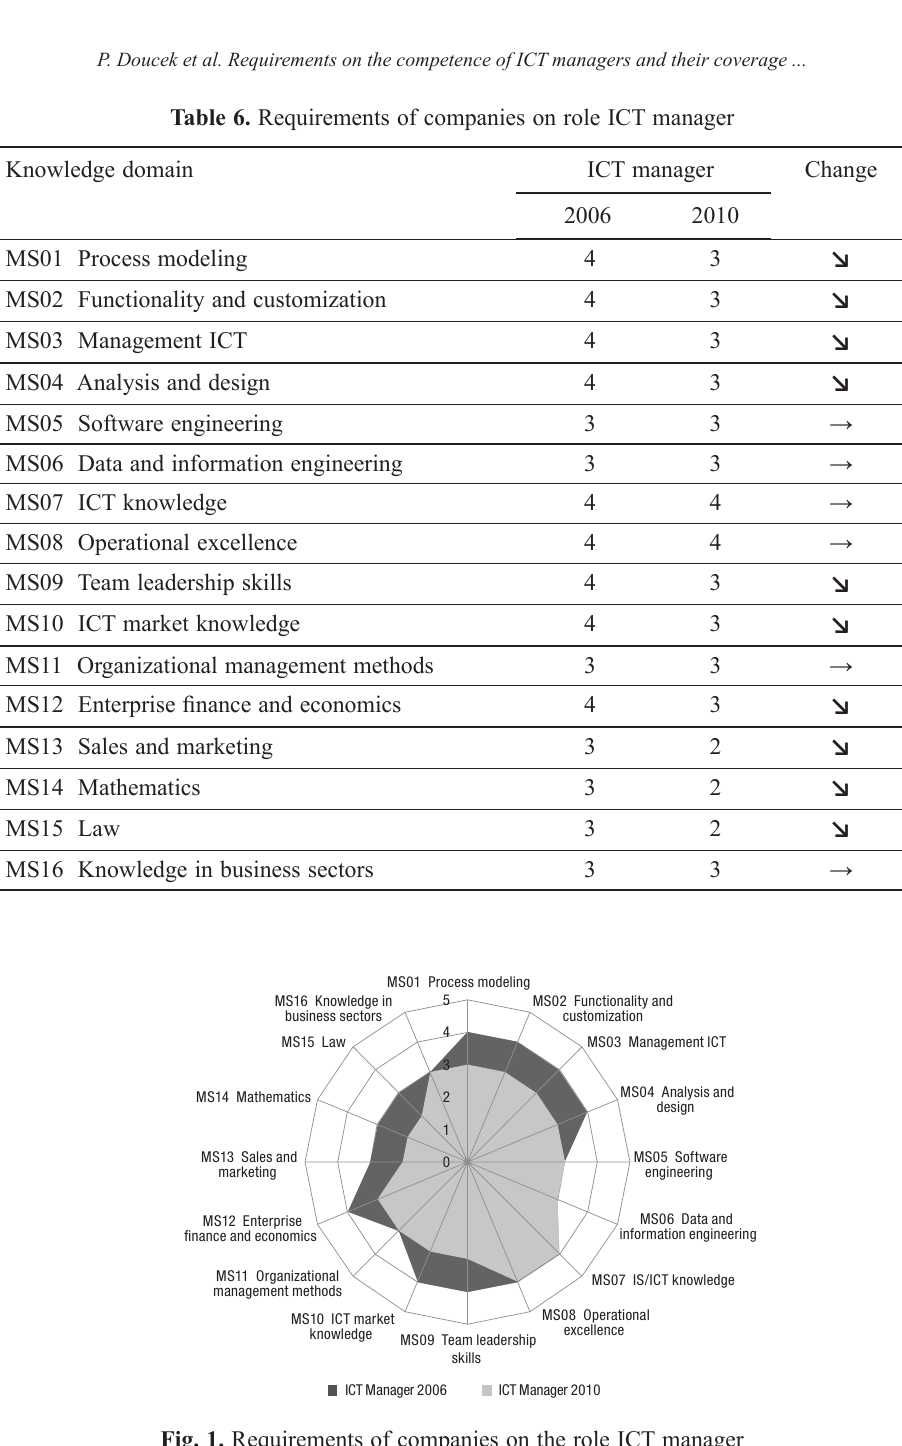
Fig. 1. Requirements of companies on the role ICT manager Source: